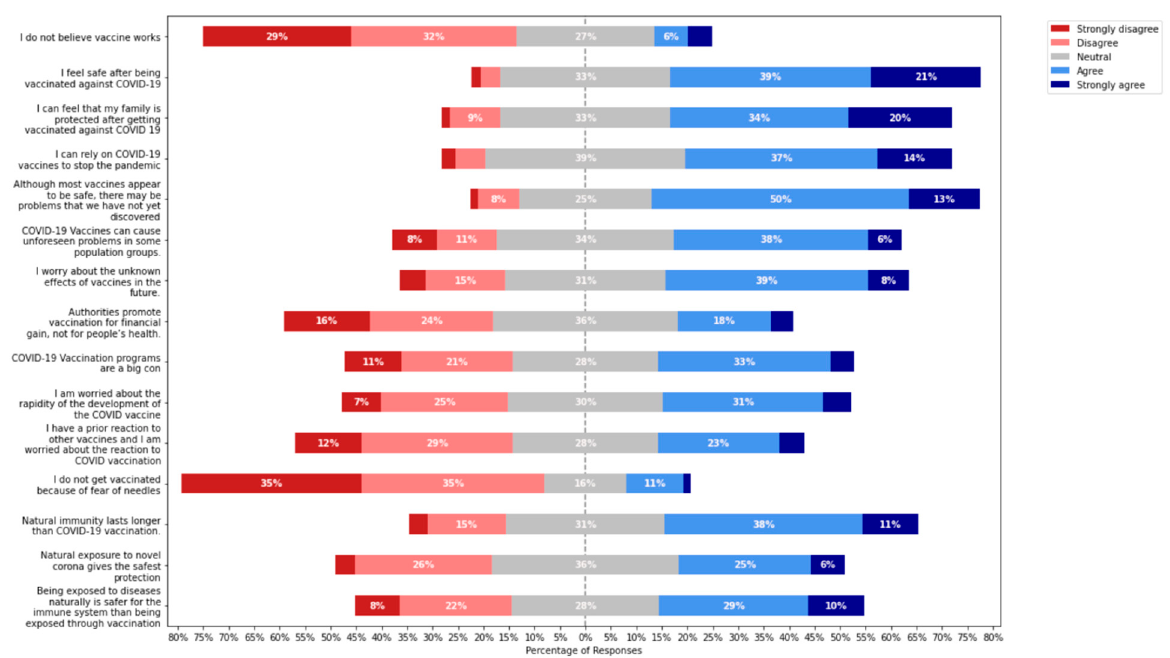
Figure 4. The Intentions toward COVID-19 vaccines among the general populations ( n = 4392).